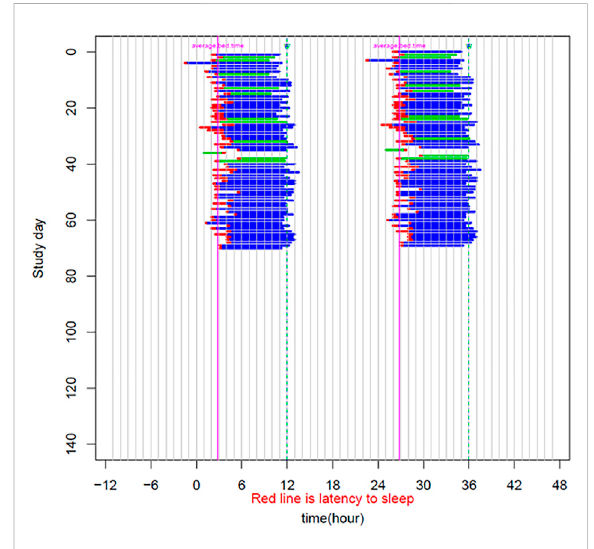
FIGURE 1 Sleep raster plot showing sleep timing (sleep onset, duration, andwake-uptime)asmeasuredwithanelectronicsleepdiaryover aperiod of70 days inthe carrier ofthers143641898 OPN4 variant. The raster plot con fi rms consistently delayed sleep onset captured over more than 10 weeks of a sleep diary.